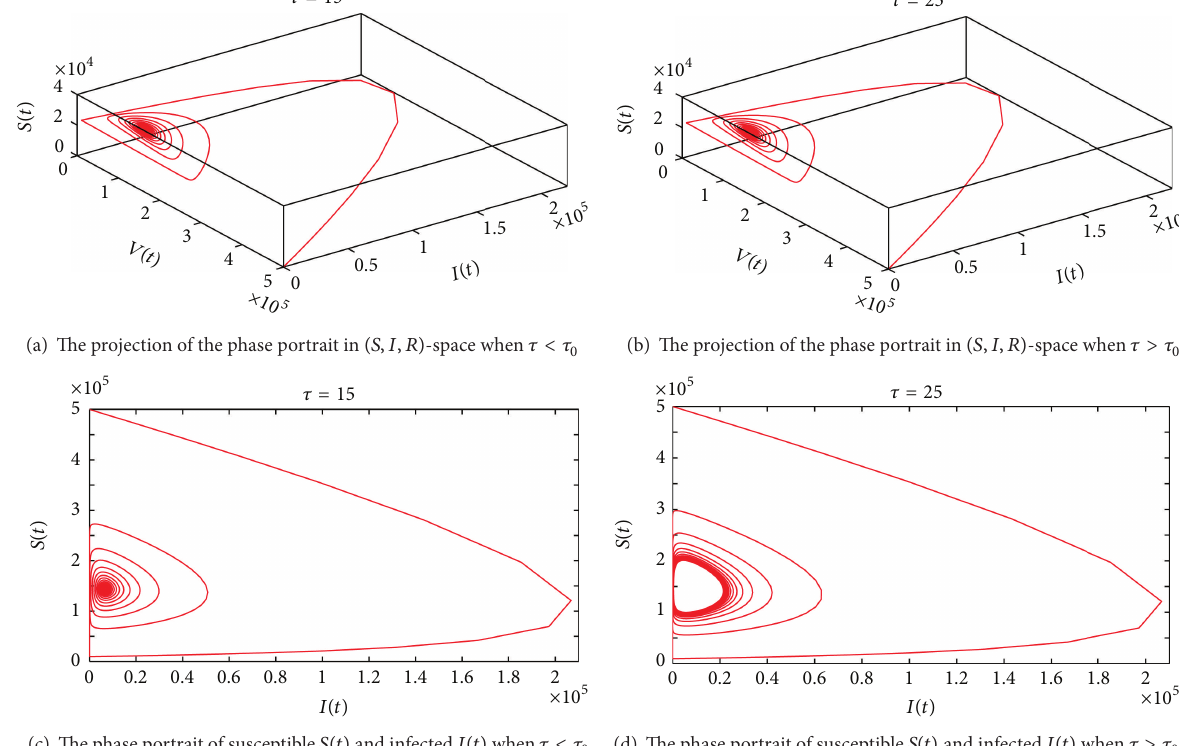
Figure 8: The phase portrait when 𝜏 < 𝜏 0 and 𝜏 > 𝜏 0 .